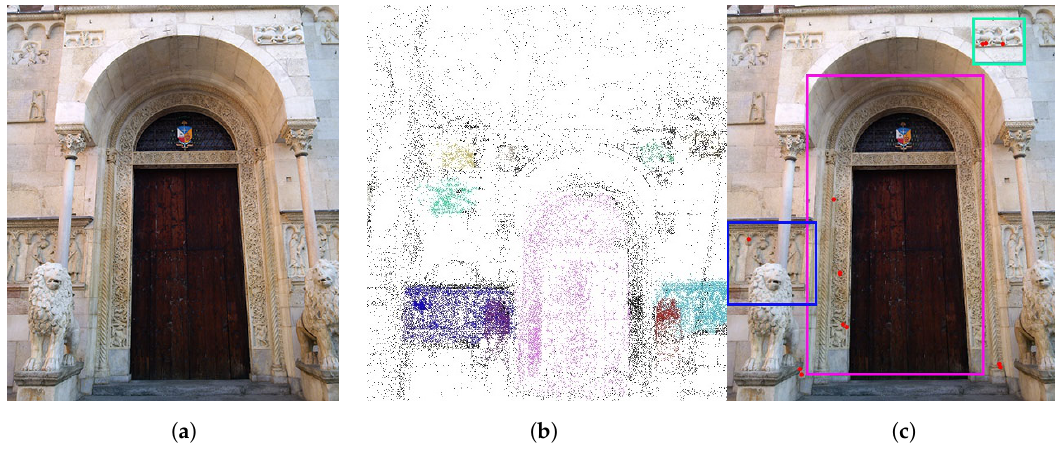
Figure 5. An example of the main steps of our retrieval system: the user query, the retrieval on the point cloud and the reprojection on the original image. ( a ) User input query; ( b ) Retrieved details on 3D model; ( c ) Reprojected points and